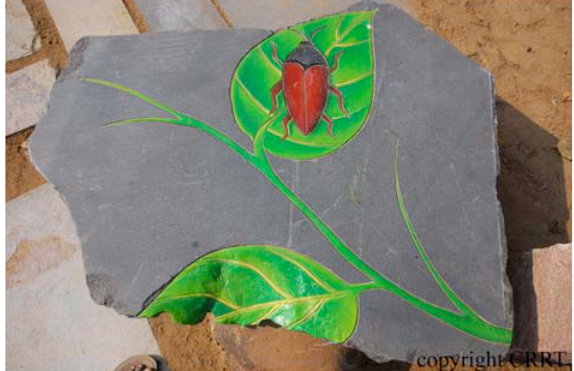
Image 12. Relief may represent form, but simple etching of outlines and painting the interior can also make a subject stand out from its surroundings. The challenge here is to use the shape of the base material to advantage and to create an ‘effect’. Here the uneven edge of discarded waste from a TAMIN factory has been used to advantage. Species represented: Jewel Beetle Sternocera sp. Tholkappia Poonga,